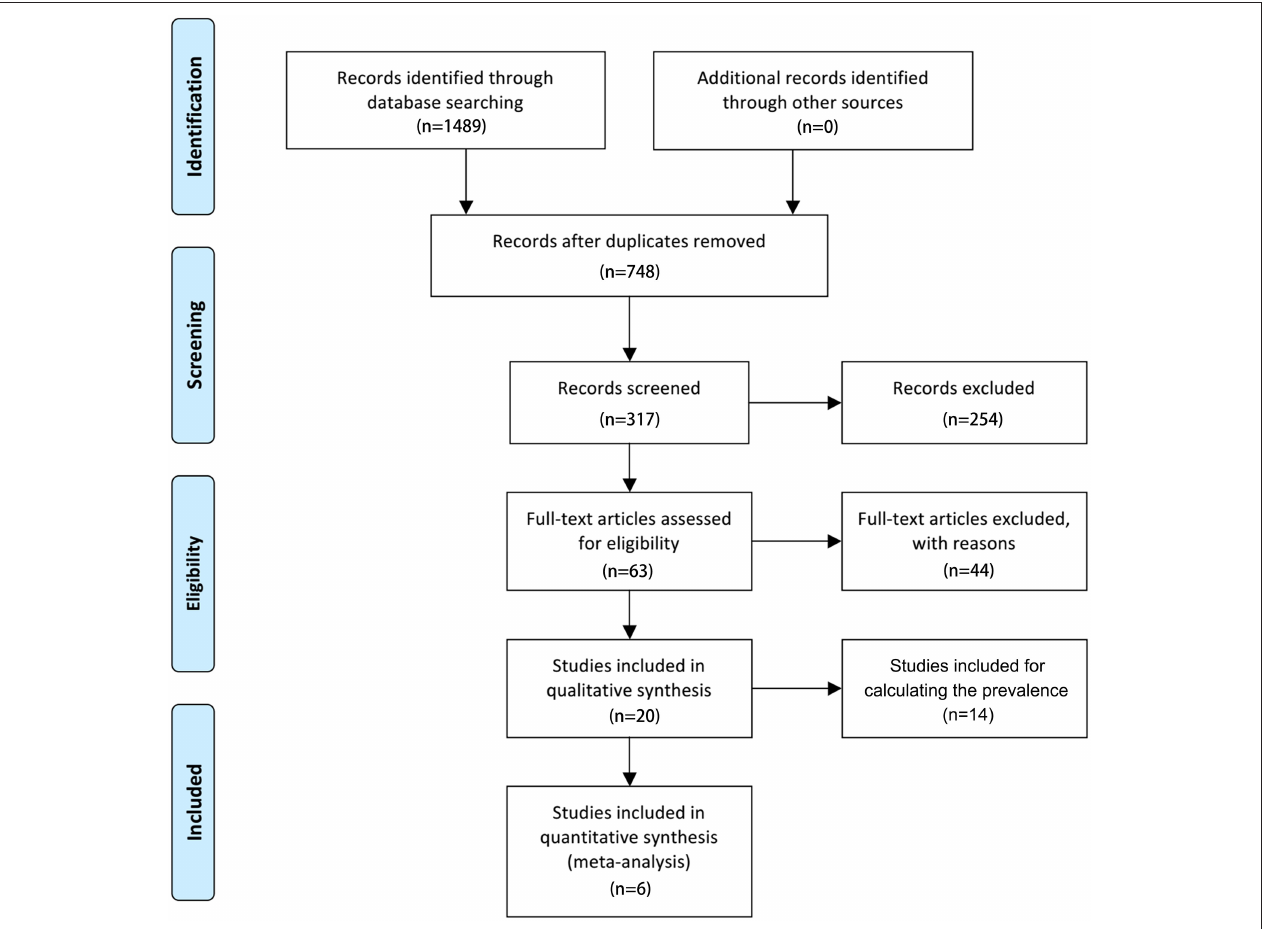
FIGURE 1 | Flowchart of the study